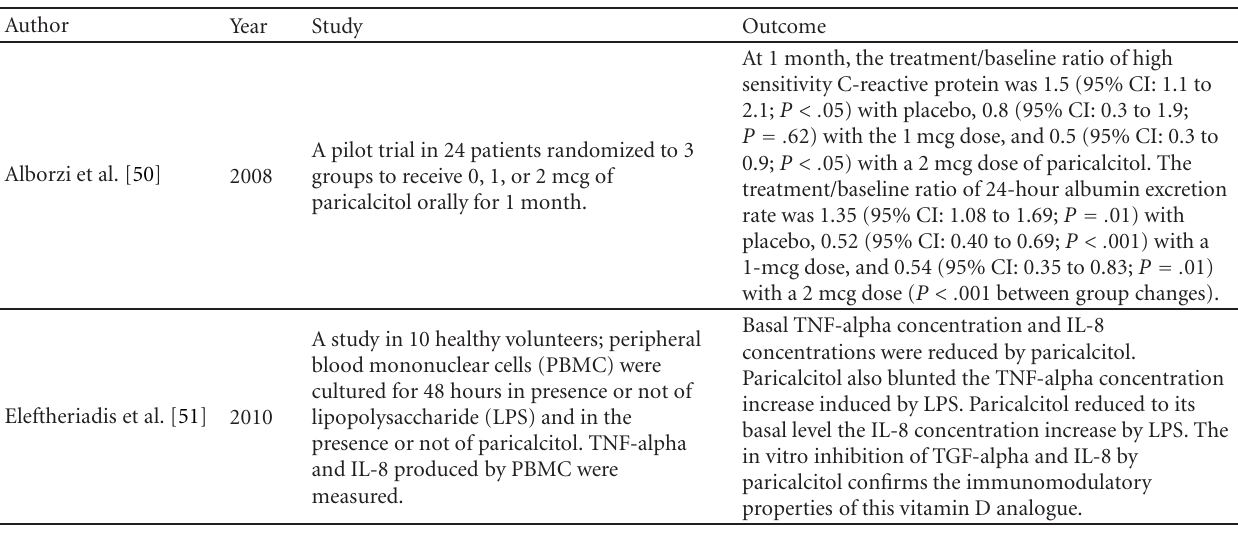
Table 13: Anti-inflammatory action.